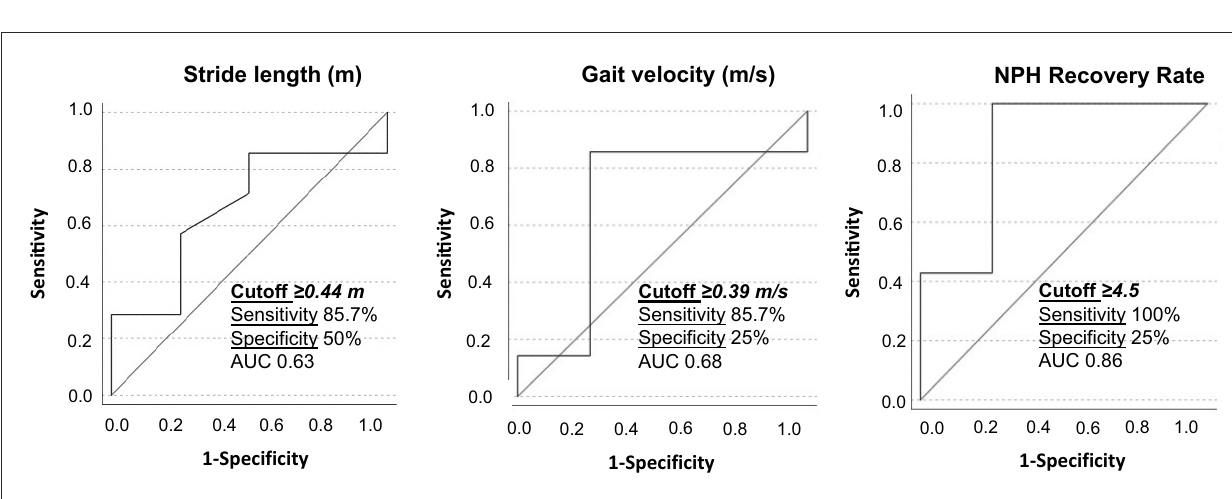
FIGURE5 Receiver operating characteristic curves for stride length, gait velocity, and NPH recovery rate between responders and non-responders to VP-shunt implantation. The respective cutoff values, sensitivity, specificity, and area under the curve (AUC) are given within the graphics.